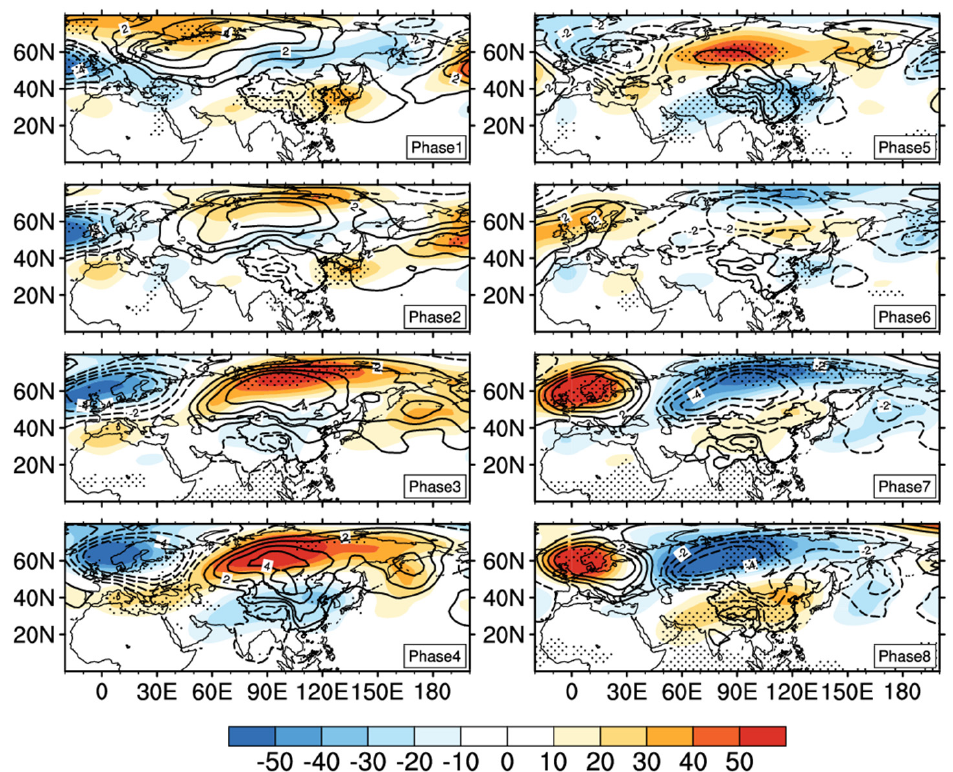
Figure 10. Temporal evolution of 30–60-d filtered 500-hPa geopotential height (shading, unit: gpm) and sea-level pressure (contours, unit: hPa) during six cold precipitation events. (Dotted areas are height passing 95% significance test.)